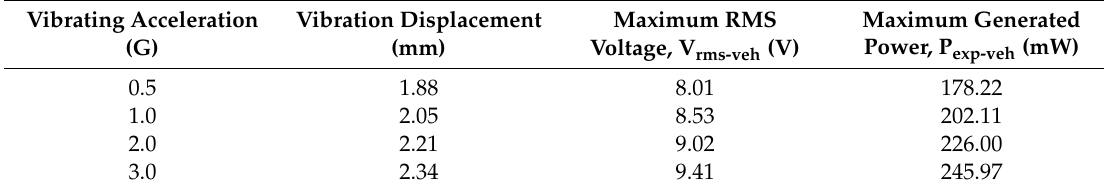
Table 2. The maximum values of the generated power with a 360 Ω load resistance (P exp-veh ) at one lower coil of the VEH device with the mechanical stopper. The maximum moving displacement of the spring was 2.0